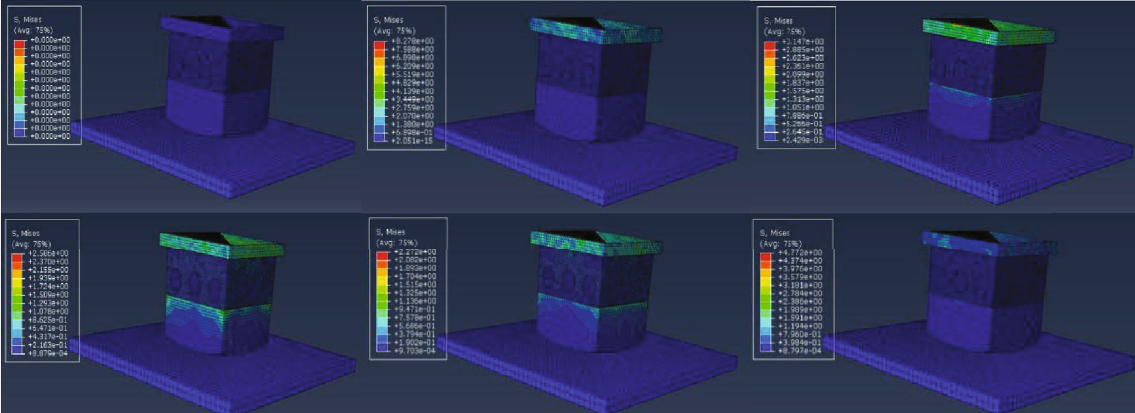
Figure 6: The simulation process of the bionic model.